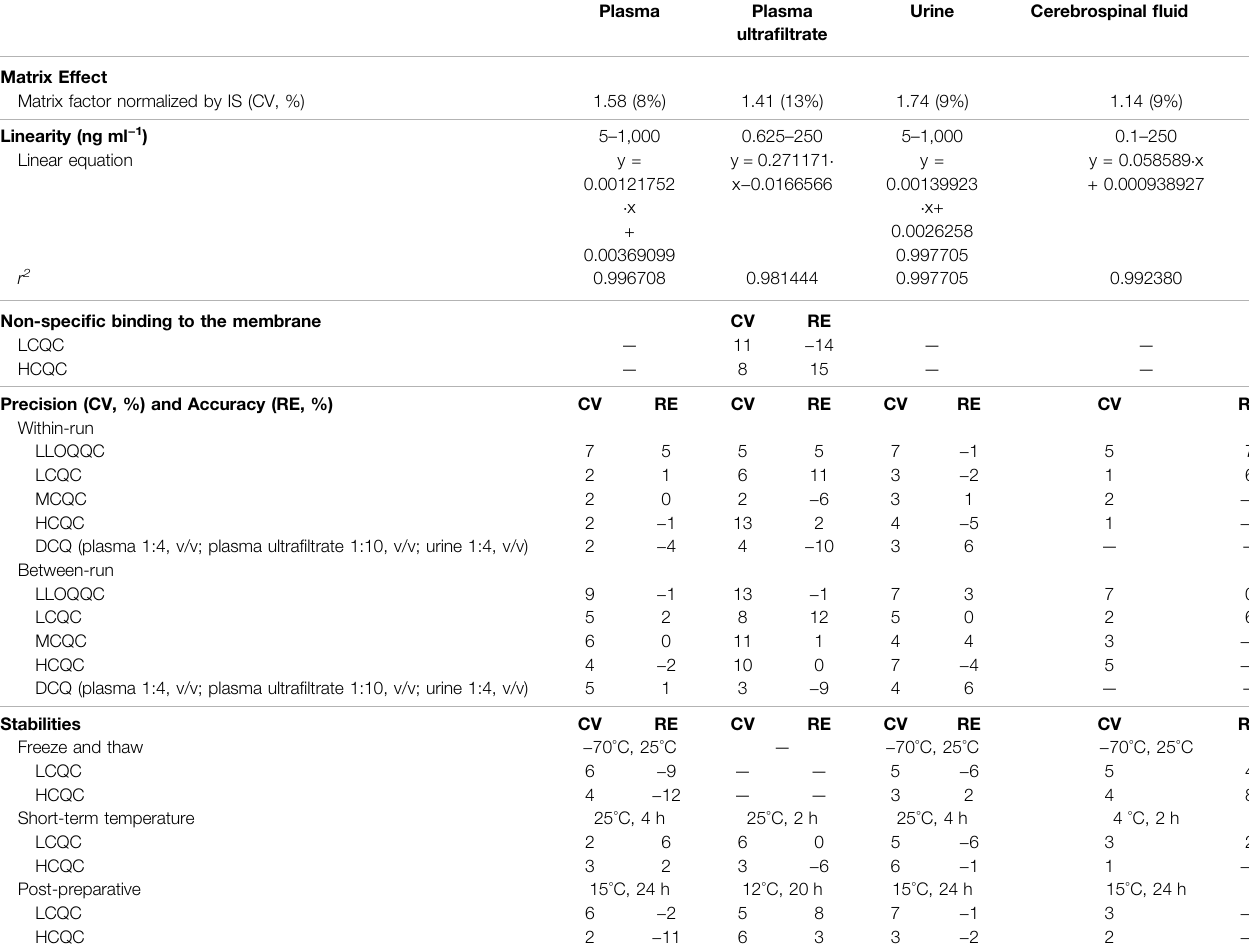
Plasma Plasma Urine ultra fi ltrate